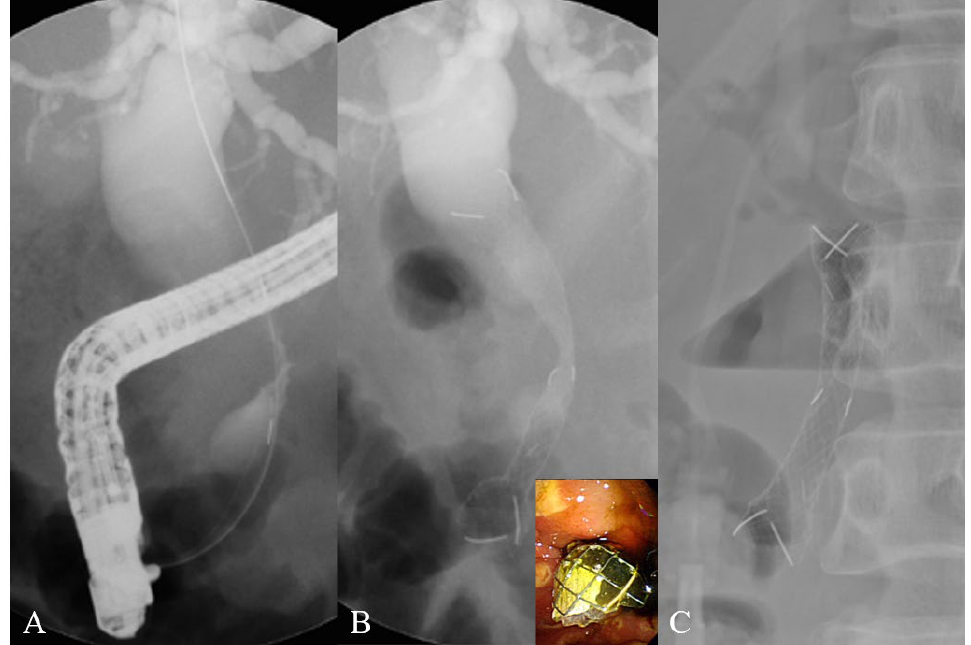
Figure 2. Insertion of a large-bore fully covered SEMS (FCSEMS-L). ( A ) The distal bile duct was obstructed by pancreatic cancer ingrowth, and the proximal bile duct was dilated. ( B ) The FCSEMS L was endoscopically inserted into the obstructed site. ( C ) The FCSEMS-L was fully deployed, and the bile duct was decompressed using an “air-biliarygram” three days after stent insertion.